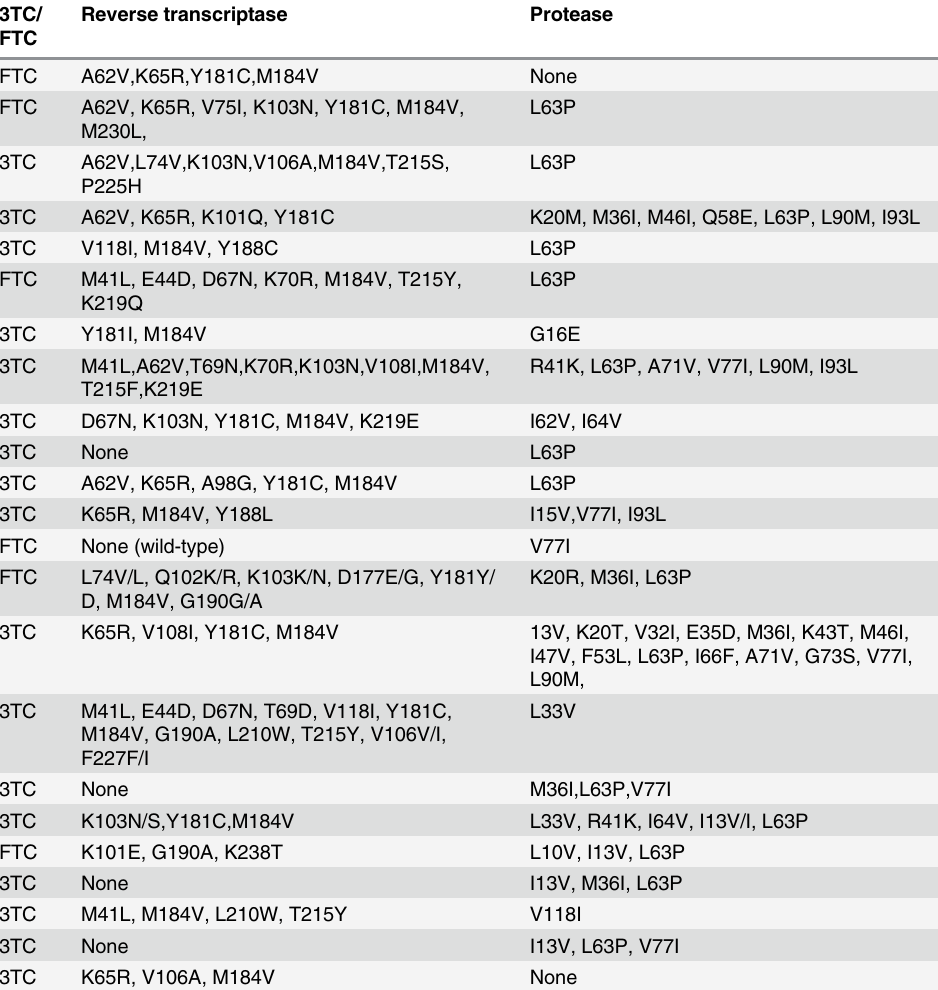
Table 3. Mutations shown at failure in the reverse transcriptase and protease, and NRTI included in the regimen together with NVP and TDF (3TC vs